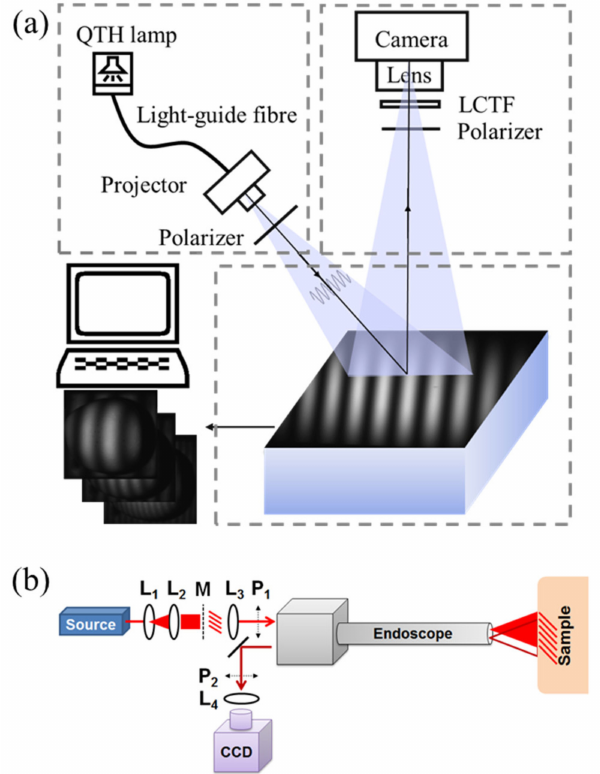
Figure 1. ( a ) Schematics of a typical SFDI system. QTH and LCTF denote quartz tungsten halogen and liquid crystal tunable filter, respectively. ( b ) Schematic of an endoscopic imaging system: a laser source is expanded and collimated by lenses L 1 and L 2 , passes through a mask of a sinusoid printed onto a transparency and is collimated by L 3 into the projection channel of the endoscope. The polarizers P 1 and P 2 ensure specular light removal. The collection channel of the endoscope sends light through L 4 where it is imaged onto a CCD camera (adapted from Ref.